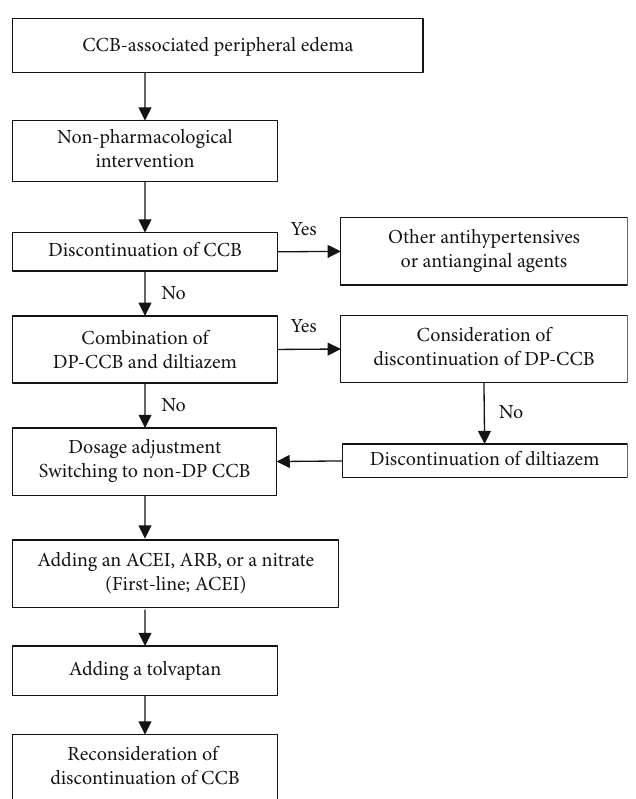
Figure 4: Treatment strategies for patients with CCB-associated peripheral edema. Abbreviations: ACE: angiotensin-converting enzyme; ARB: angiotensin II receptor blocker; CCB: calcium channel blocker; DP: